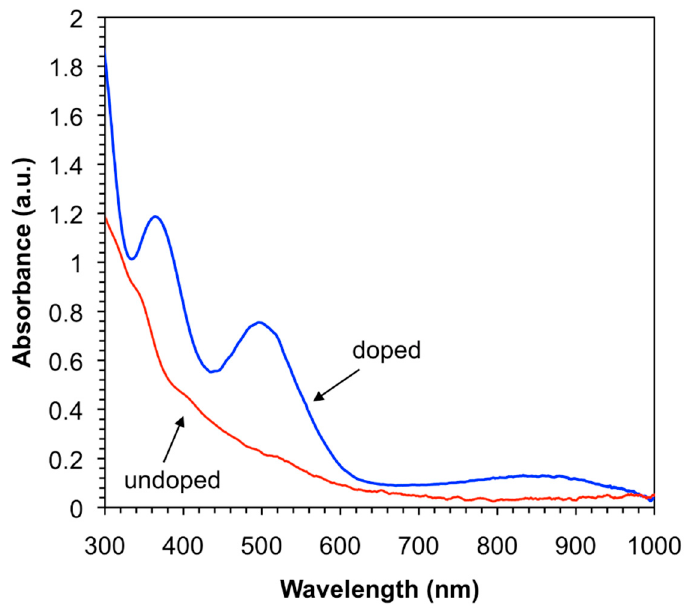
Figure 6. UV-vis-NIR spectra before and after doping with I 2 the xerogel prepared from the organogel made of 14 in DCM (29 g/L).